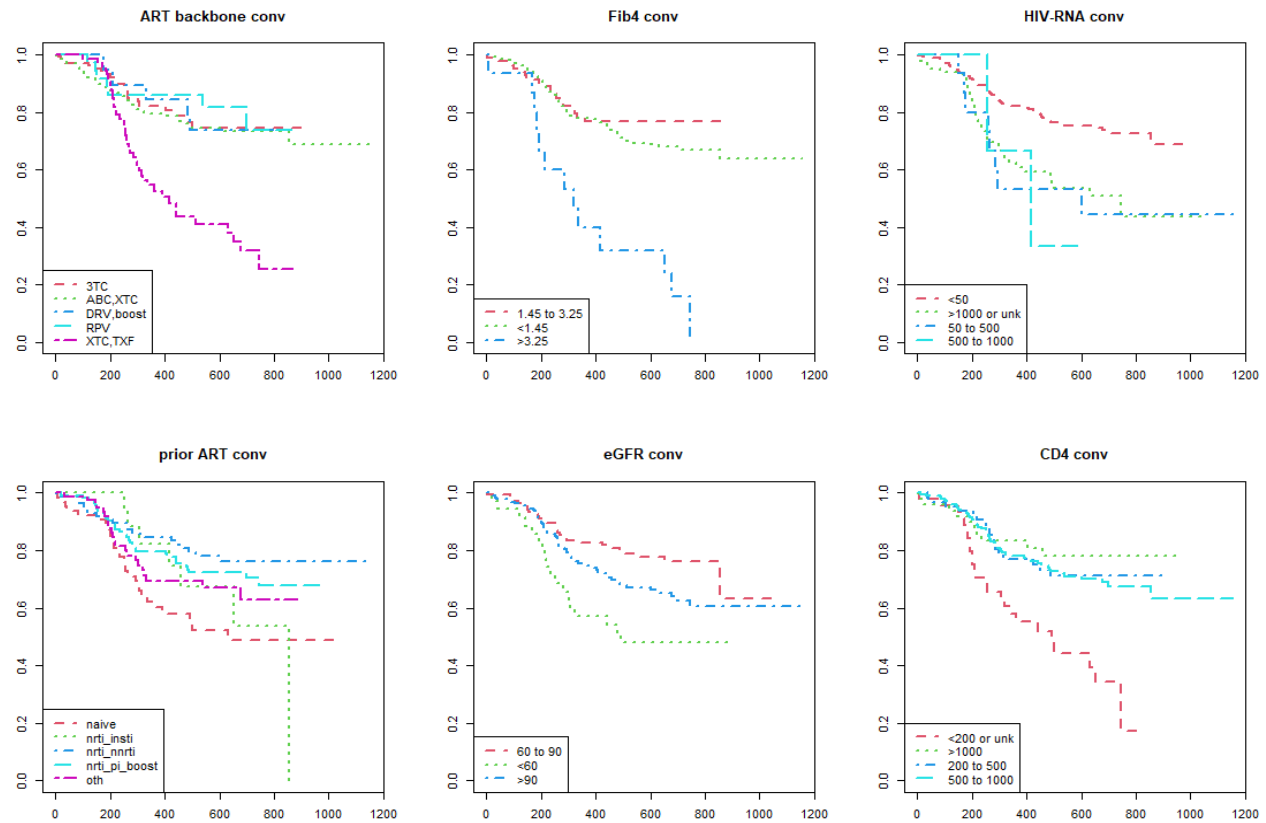
Figure 3. Kaplan–Meier survival curves show the time to a convenience event of dolutegravir-based antiretroviral therapies among people with HIV enrolled in the Italian MaSTER cohort. Plots are stratified by: ART backbone, FIB4 score, HIV RNA, previous ART, eGFR, CD4+ T-cell count. CONV, convenience; ART, antiretroviral treatment; NRTI, nucleos(t)ide reverse transcriptase inhibitors; NNRTI, non-nucleos(t)ide reverse transcriptase inhibitors; INSTI, integrase strand inhibitors; PI, protease inhibitors; RPV, rilpivirine; TXF, tenofovir alafenamide or tenofovir disoproxil fumarate; XTC, emtricitabine or lamivudine; 3TC, lamivudine; ABC, abacavir; DRV, darunavir; Boost, ritonavir-boosted regimens; OTH, other; eGFR, estimated Glomerular Filtration Rate. X -axis: time (days); Y -axis: survival rate (%).